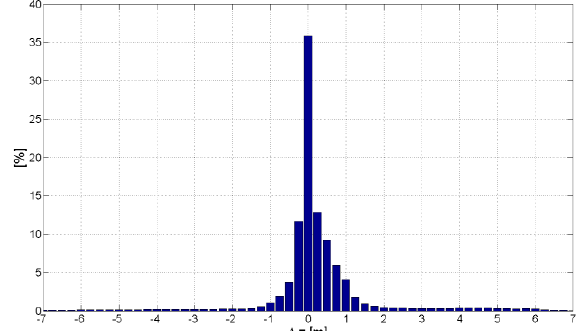
Figure 3. Histogram of the height differences in the northern test site with height variations between -13.8 m and 8.5 m (values <7m (0.35%) and >7m (0.06%) are not shown) In the western test site, the height differences between the DTM of 2004 and 2010 are lower. The values vary between -3.9 m and 3.4 m (Fig. 6). The mean of the differences is 0.05 m with a standard deviation of 0.35 m. At seaside, height differences might be caused by different water levels during the acquisition time. This assumption is confirmed by a constant height difference in the tidal channel in the south of the test site. However, the border of the island shows significant topographic changes. At the northern border, sedimentations between 2.0 m and 3.5 m occur over a length of 20 m. The height differences at the western border vary between 1.0 and 2.0 m. Fig. 5 shows the results of the edge detection from both DTMs. In comparison to the northern test site the shift of the border is lower, it is in the range of few meters. Moreover, the edges move predominantly towards seaside between both epochs.